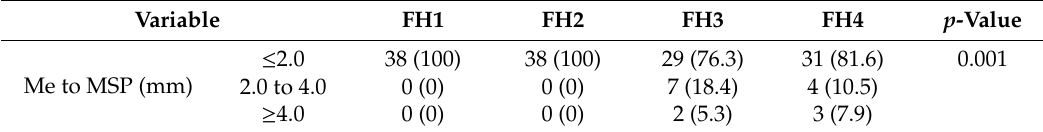
Table 5. Frequency change of the amount of mention (Me) deviation according to each FH